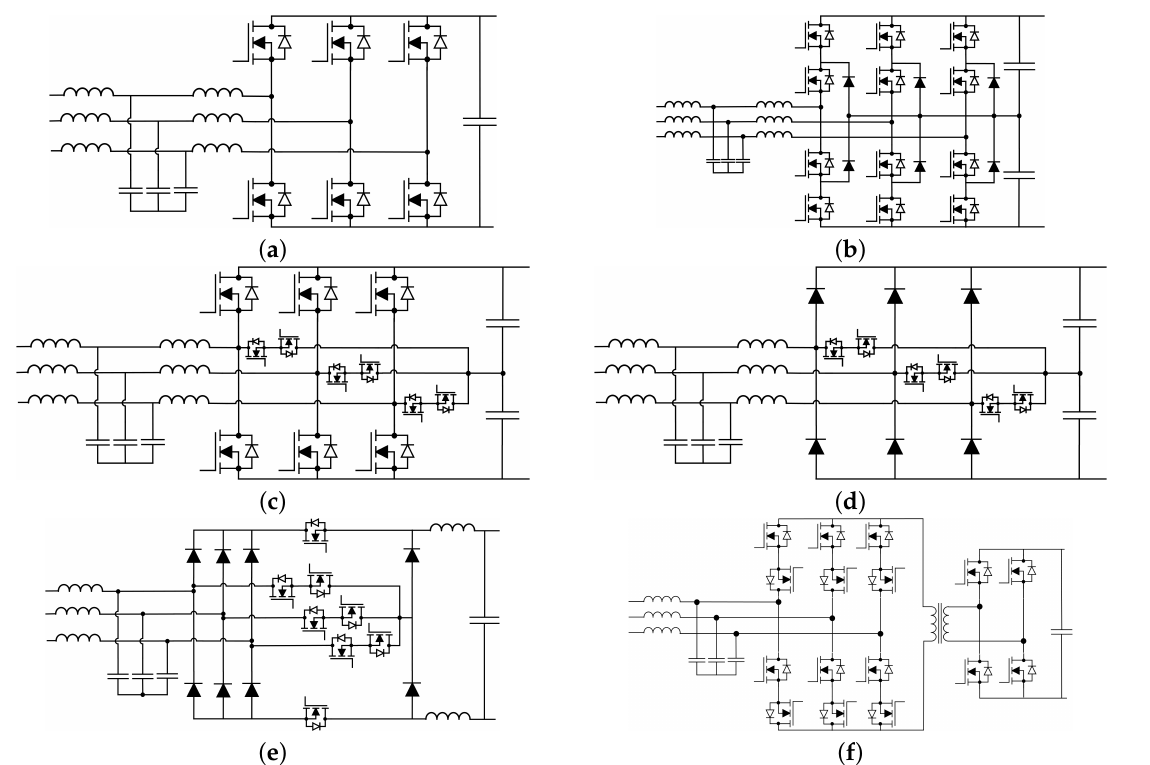
Figure 4. Different AC/DC conversion topologies connected to a three-phase AC grid. Grid drawings are omitted for visual clarity: ( a ) Two-level active front end (AFE); ( b ) Three-level neutral point clamped (NPC) AFE; ( c ) Three-level T-type AFE; ( d ) Vienna rectifier; ( e ) Swiss rectifier; ( f ) Matrix Converter-based isolated AC/DC converter